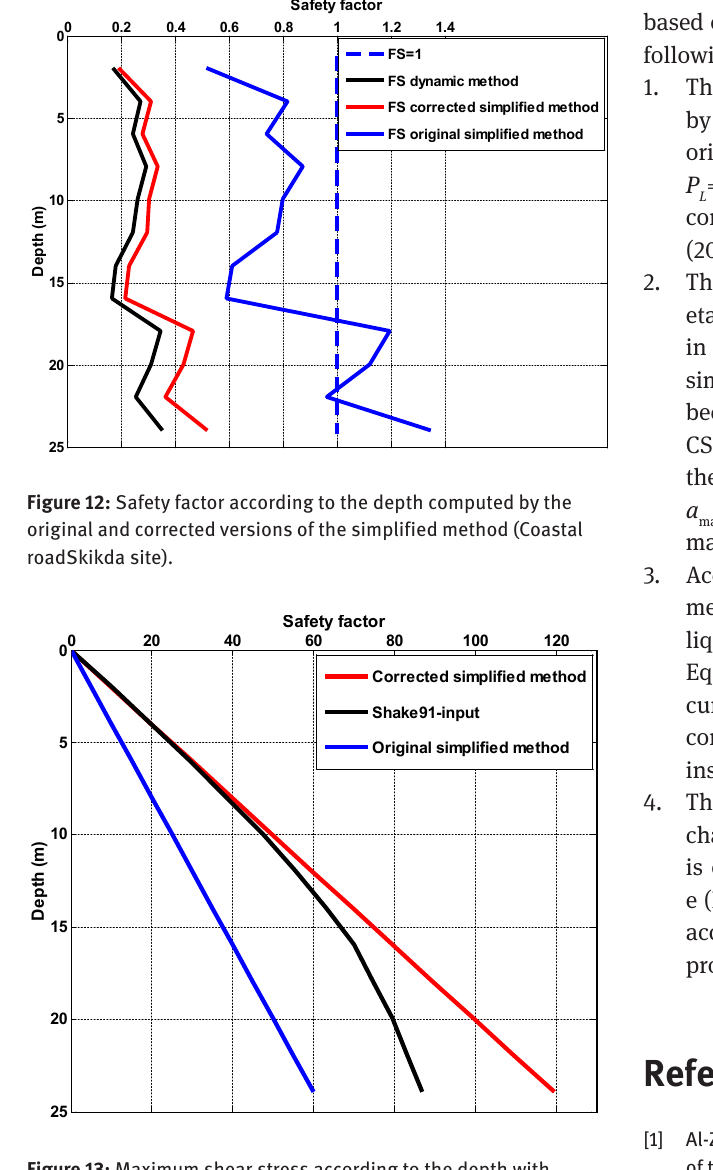
Figure 13: Maximum shear stress according to the depth with dynamic and simplified analysis (Coastal road Skikda